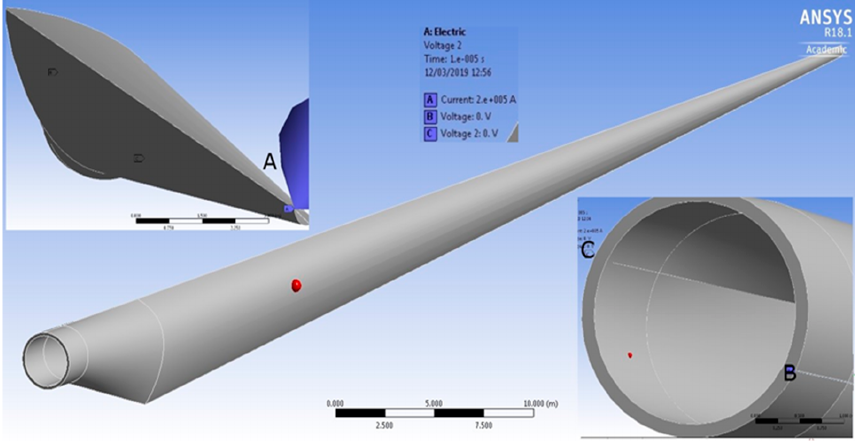
Figure 1. Wind turbine blade for simulation.